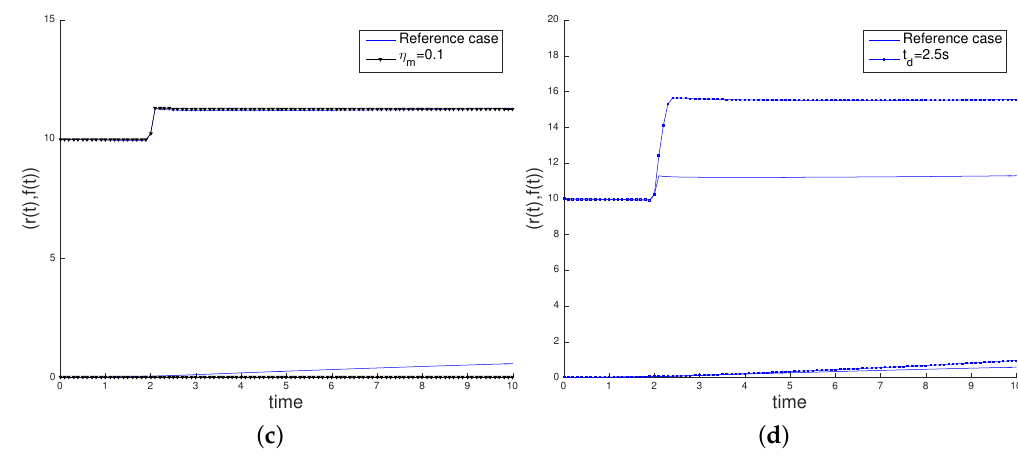
Figure 8. Sensitivity analysis of the proposed model. Time evolution of the rear and front ends of the cell are shown. The solid line corresponds to the reference case introduced in Section 3. ( a ) reference case and three new scenarios; ( b ) reference case vs. increased initial cell length; ( c ) reference case vs. decreased myosin stress; ( d ) reference case vs. delayed deactivation